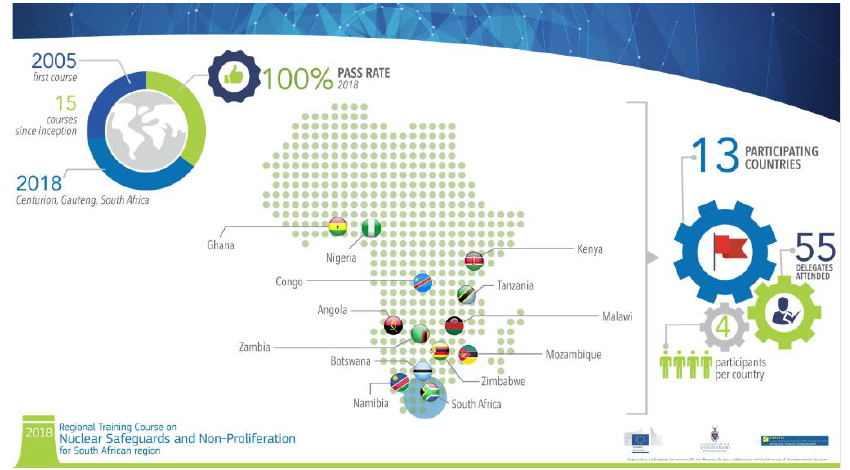
Figure 4: Participation to the ESARDA course in Centurion, South Africa, February 2018.